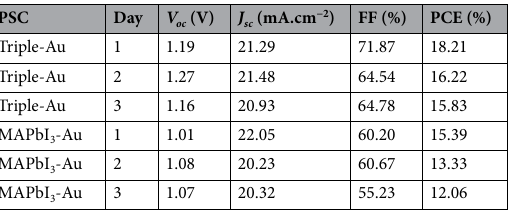
Table 2. Time dependent PCE values of triple and MAPbI 3 based PSCs with